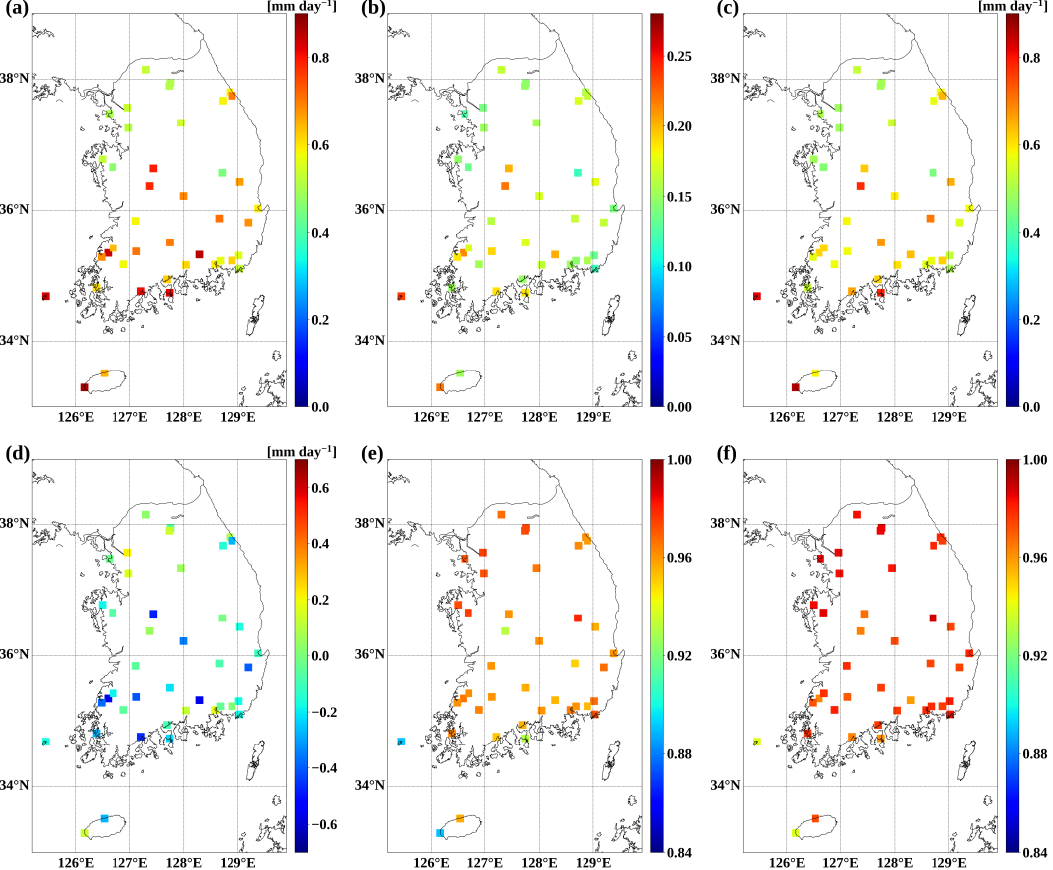
Figure 8. Spatial representation of the comparison between GK2A/AMI satellite-derived PET, and PET from ASOS stations operated by KMA, for the period 25 July 2020 to 31 July 2021. Accuracy is represented by ( a ) RMSE, ( b ) nRMSE, ( c ) STD, ( d ) bias, ( e ) Pearson’s R , and ( f ) IOA.